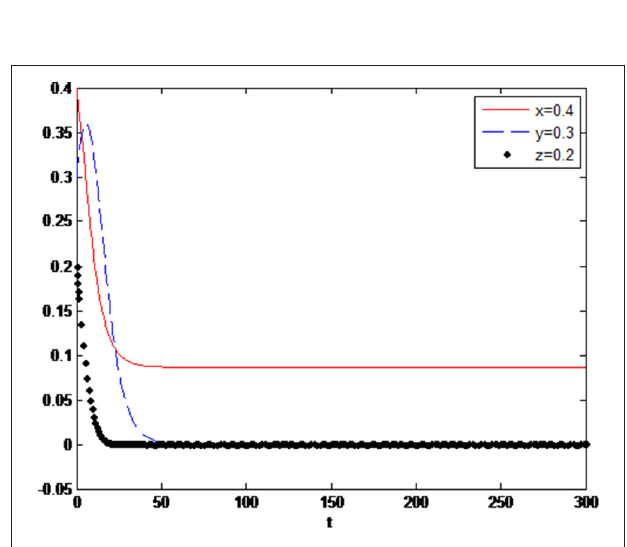
FIGURE 6 | In case of c 2 = 0.8, π ′ 1 =